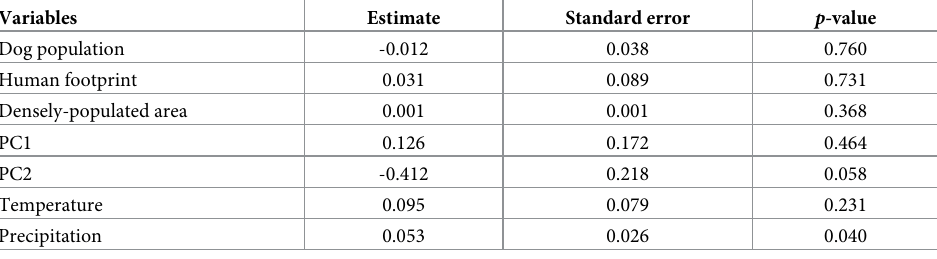
Table 3. Univariable analysis results for dog rabies cases in South Africa between 1998 and 2002 including the Kruger National Park. Variables Estimate